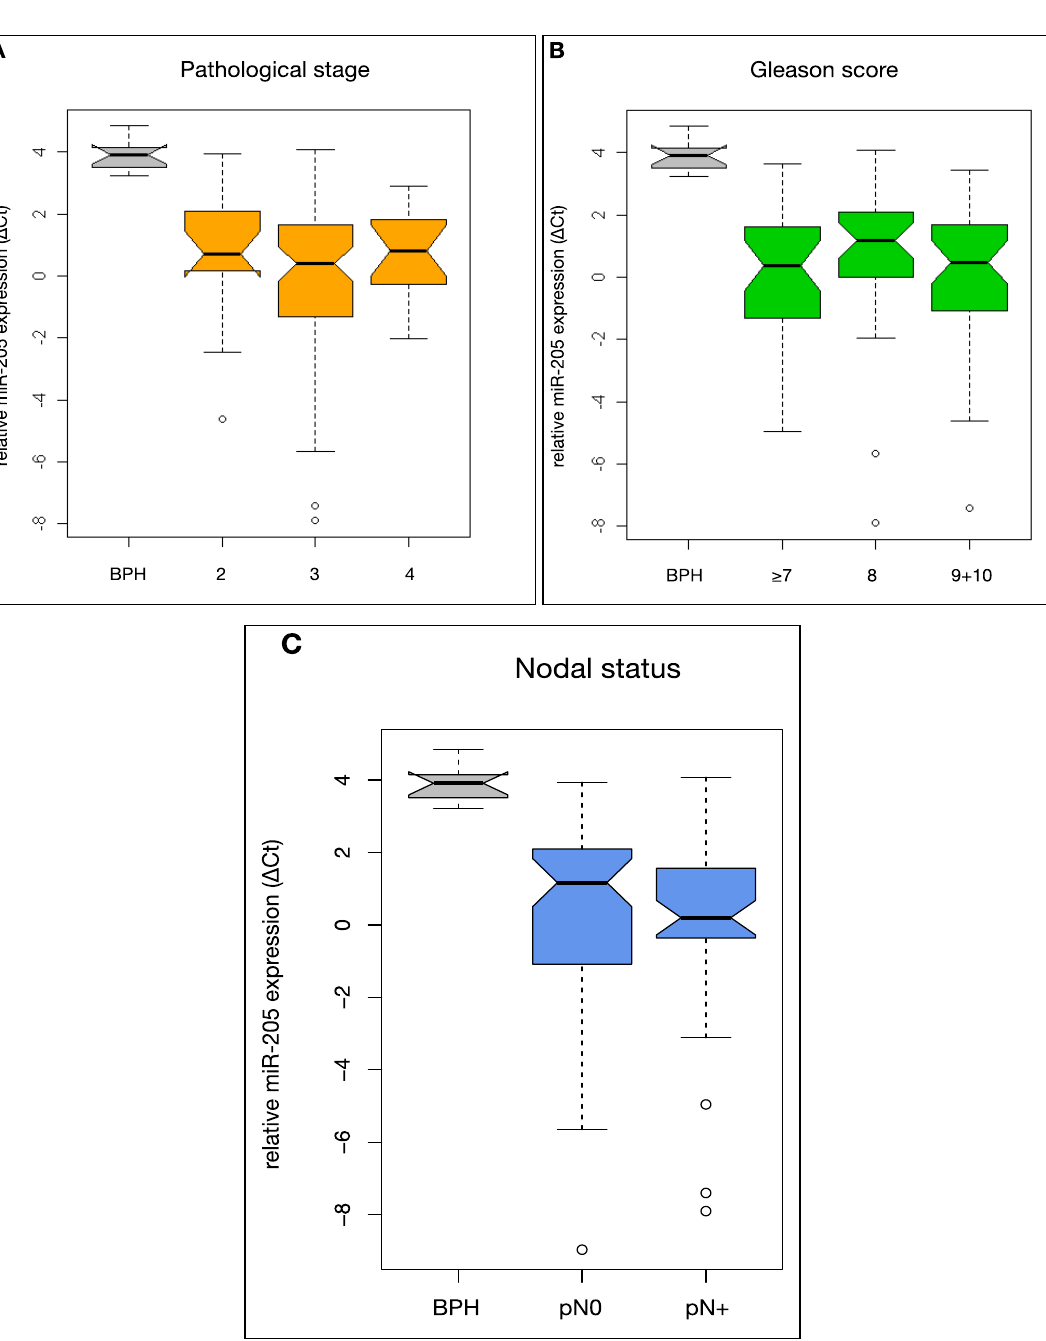
Figure 3. MiR-205 expression as related to different clinical parameters in the study cohort ( n = 105). Relative miR-205 expression was analysed in all samples by the Δ C t method using qRT-PCR. ( A ), ( B ) and ( C ) Boxplots showing the relation of miR-205 expression with the pathological tumour stage, Gleason score and the nodal status of the primary tumour in the study cohort in comparison to that in 10 BPH tissues. p -values were calculated using one-way ANOVA ( A and B ) and Student’s unpaired t -test ( C ). ( D ) and ( E ) Dot plots showing the association of miR-205 expression with preoperative PSA-values and age at